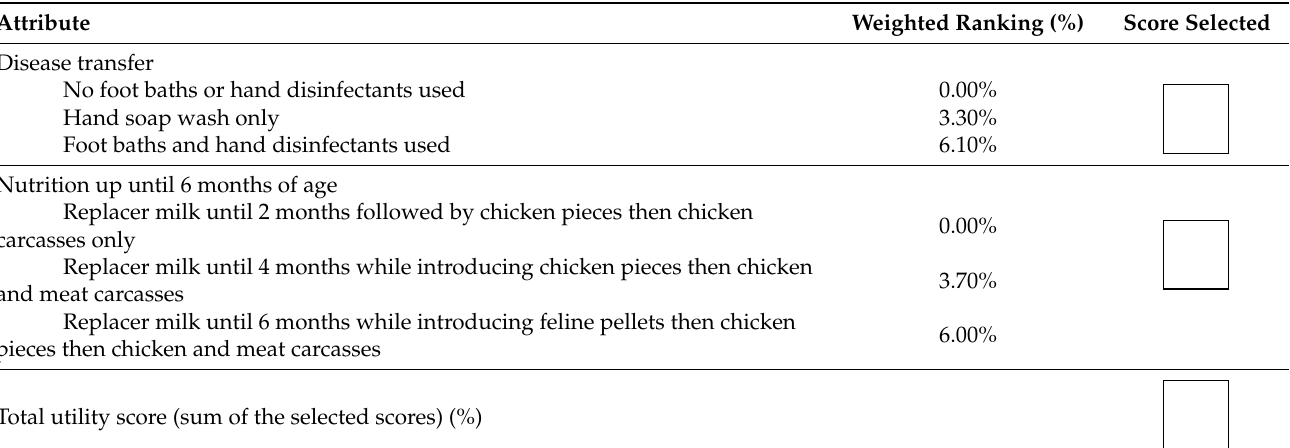
Table 4. Cont. Table 4. A value model (%) for rating the welfare of lion cubs used in tourism (wildlife interaction facilities).